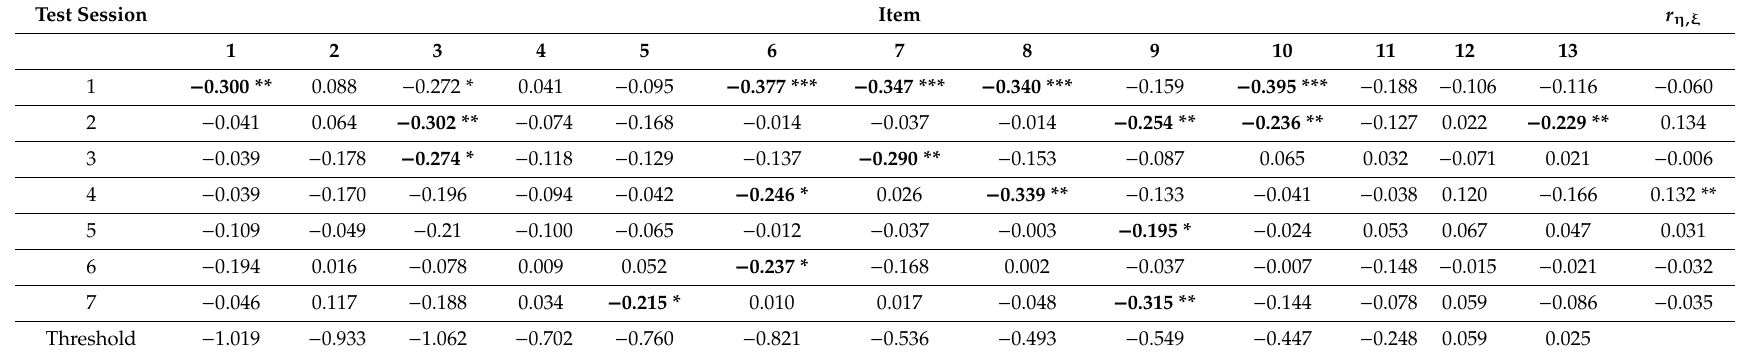
Table 4. Standardized interference e ff ects and correlations of latent ability and anxiety (deficit e ff ects) of the full interference